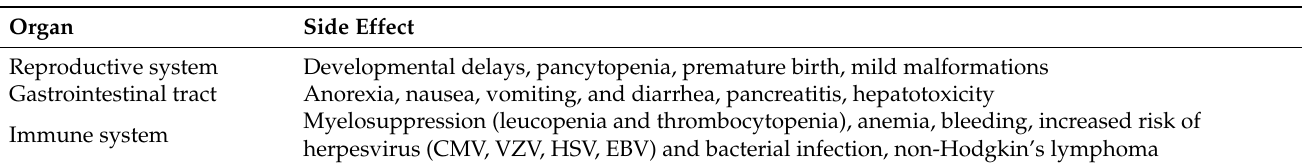
Table 5. Summary of Organ-Specific Side Effects of Azathioprine